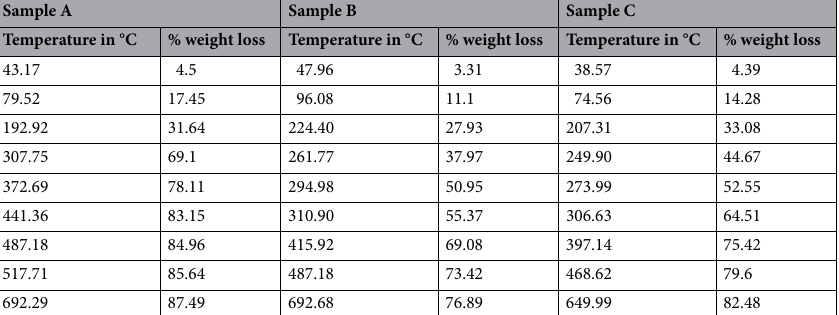
Sample A Sample B Sample